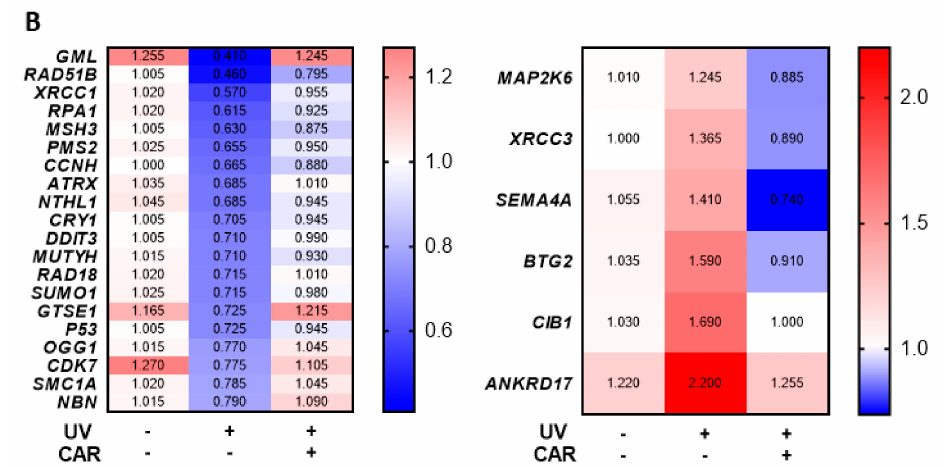
Figure 4. E ff ect of carvedilol on UV-mediated epidermal thickness, Ki-67, and p53 expression, and the expression of genes of DNA damage signaling in 3D human reconstituted skin culture (EpiDermTM FT-400). The reconstituted human full thickness skin was treated with UV (60 mJ / cm 2 ), with or without carvedilol (CAR, 5 µ M) for 24 h (see Materials and Methods for details). ( A ) H&E staining of EpiDermTM FT-400 3D human skin culture sections to quantify the epidermal thickness. The green arrows indicate the measurement of epidermal thickness. Skin sections were also analyzed with immunohistochemistry to detect Ki-67 or p53 positive cells. Representative sections of immunostaining are shown. Data were obtained from one sample from each treatment group ( n = 1). The plots or bars with a di ff erent letter are significantly di ff erent from each other at the level of p < 0.05 as per two-way Analysis of variance (ANOVA) with Tukey’s post hoc test. ( B ) Profiling of DNA damage signaling genes by the RT 2 Profile PCR array. RNA isolation and PCR array analysis were carried out on three treatment groups (vehicle control, UV control, and UV + carvedilol) ( n = 2). The signal intensities of each protein were normalized by those of glyceraldehyde 3-phosphate dehydrogenase ( GAPDH ) and the fold change was calculated between the treated and vehicle control samples. A heat map was constructed using 2 − ∆∆ C t for the selected genes showing the highest fold